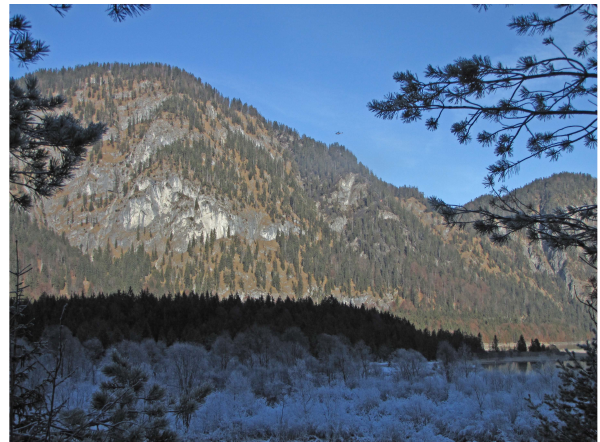
Fig. 7. Mop-up operations are in progress after the Sylvenstein Reservoir fire (near the ridge at the centre of the image) on 23 November 2011, at noon, while rime covers the vegetation in the valley (foreground).